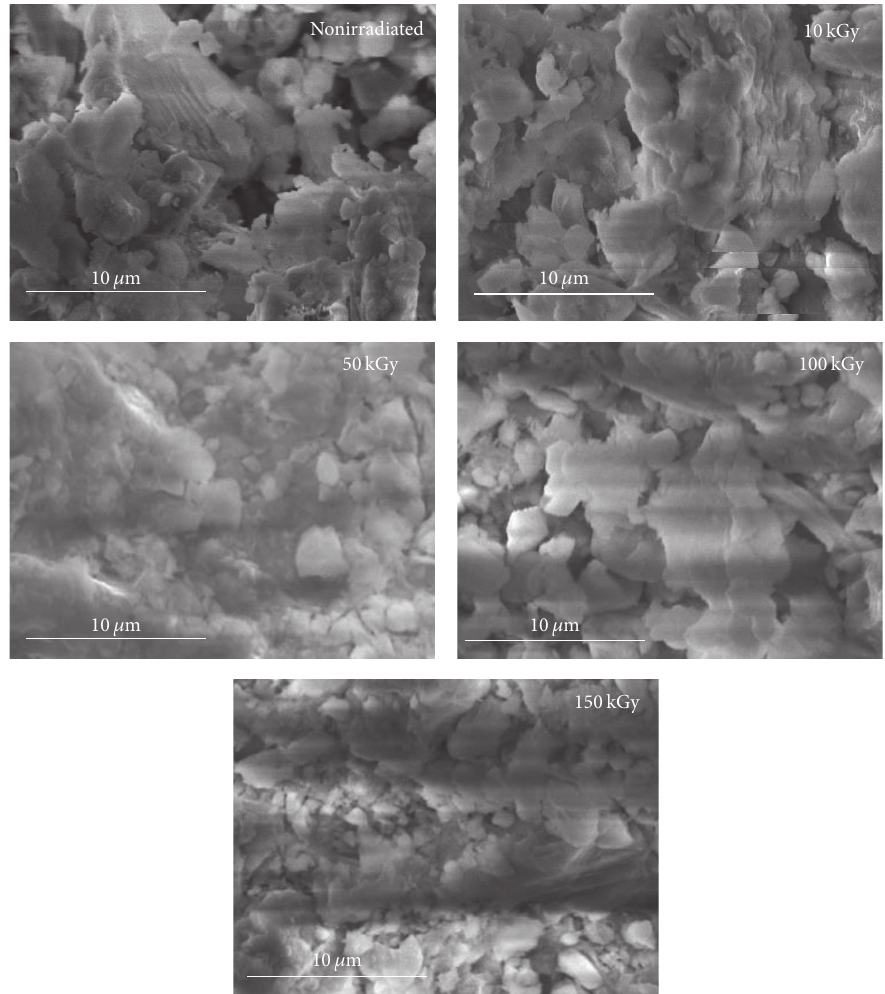
Figure 3: SEM images of nonirradiated and irradiated